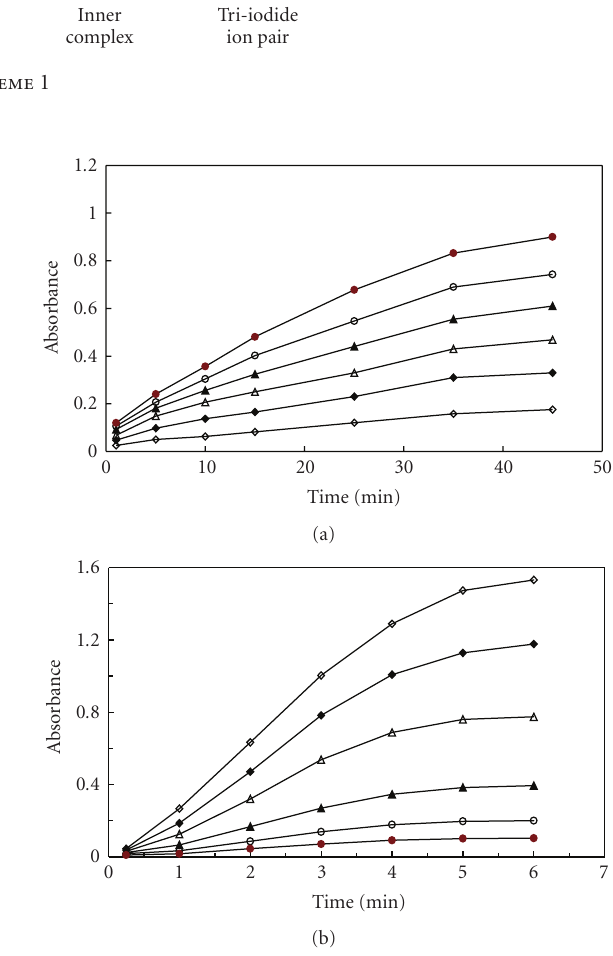
Figure 3: The absorbance-time curve for the reaction of OMZ at 25 ± 2 ◦ C with (a) iodine (0.20mg mL − 1 ) at 362 nm; the concentrations of OMZ were 1 . 45 × 10 − 6 ( (cid:5) ), 2 . 90 × 10 − 6 ( (cid:2) ),